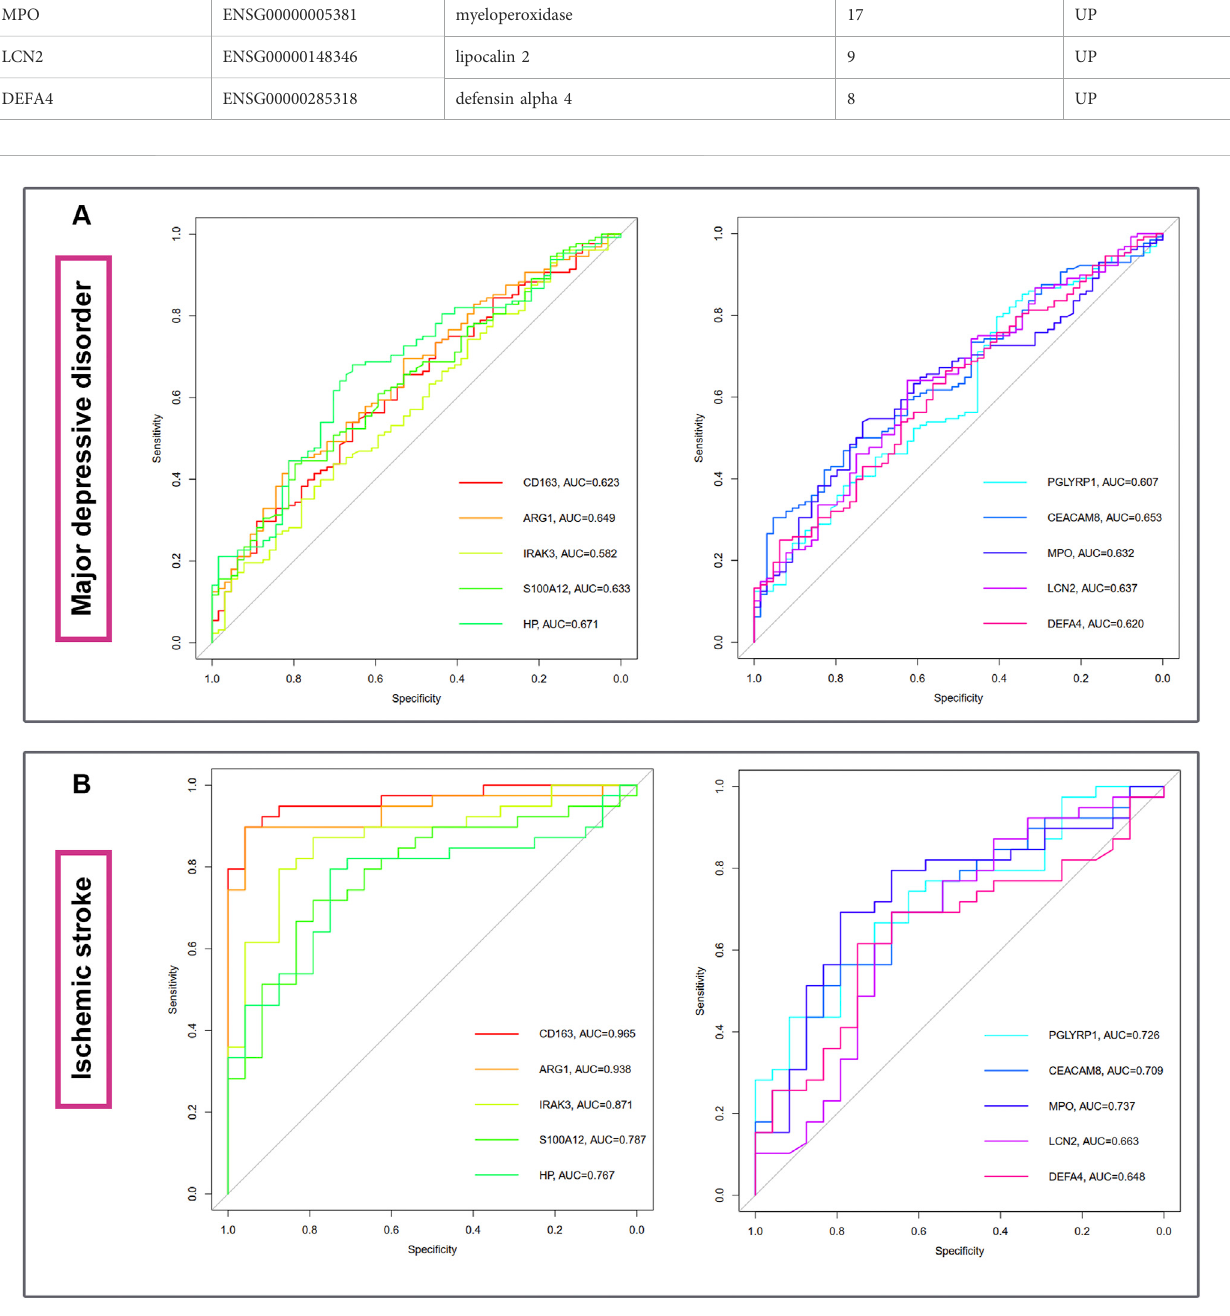
FIGURE 7 The diagnostic abilities of the ten hub genes in MDD (A) and IS (B) with ROC curve. ROC, receiver operating characteristic.